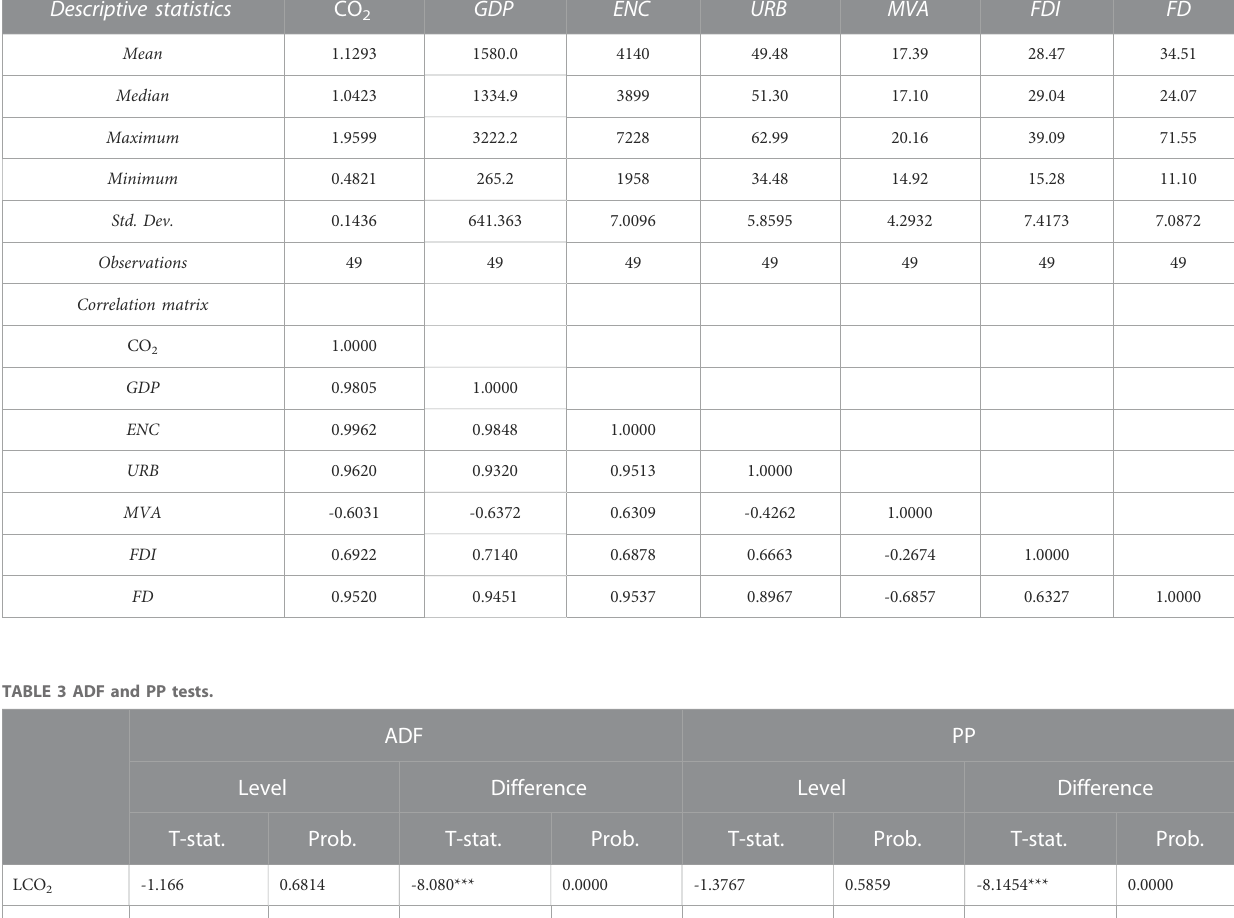
TABLE 2 Descriptive Statistics and correlation matrix. Descriptive statistics